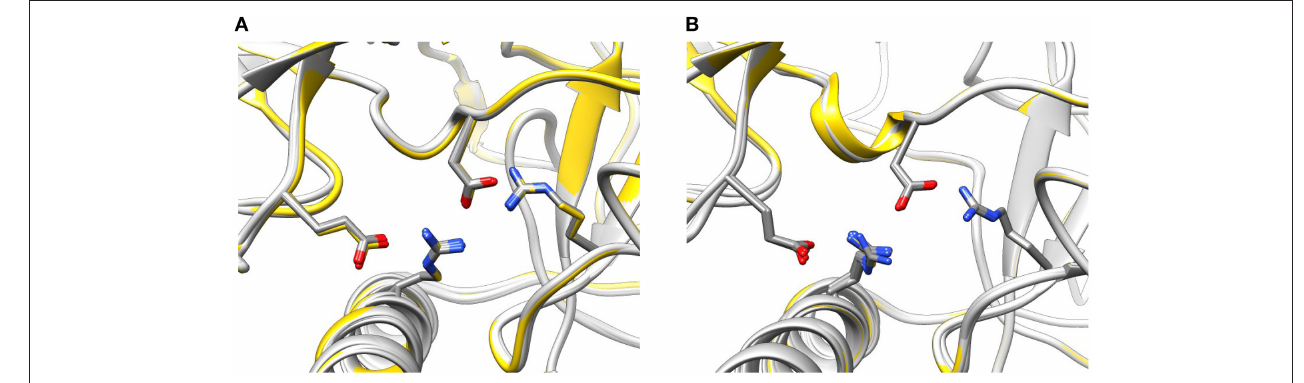
FIGURE 6 | Configuration of the interaction network D61—R417—E40—R298 in mutant NTRs. (A) Wild type (yellow) and mutant (light gray) NTR models in the closed (A) and open state (B) .